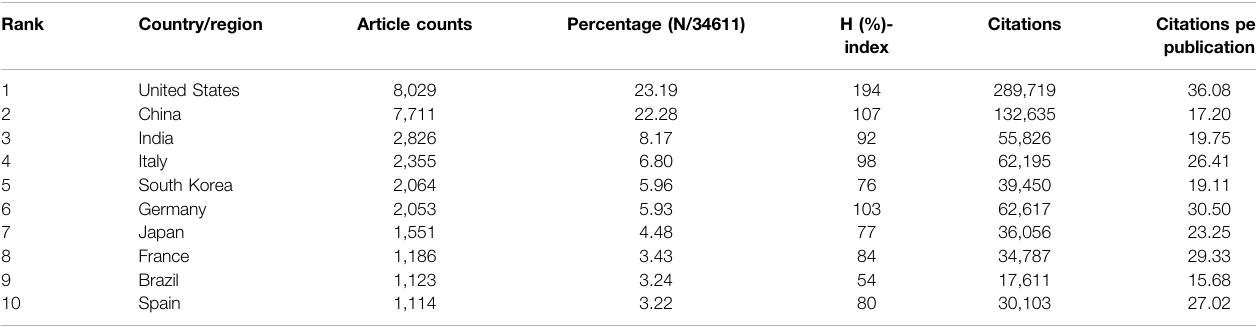
TABLE 1 | The top 10 productive countries/regions related to natural products in cancer